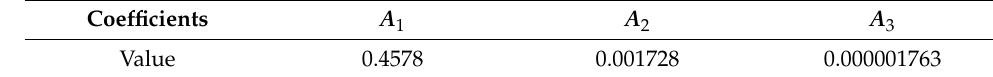
Table 4. Parameters of the correction coefficients in Equation (37).